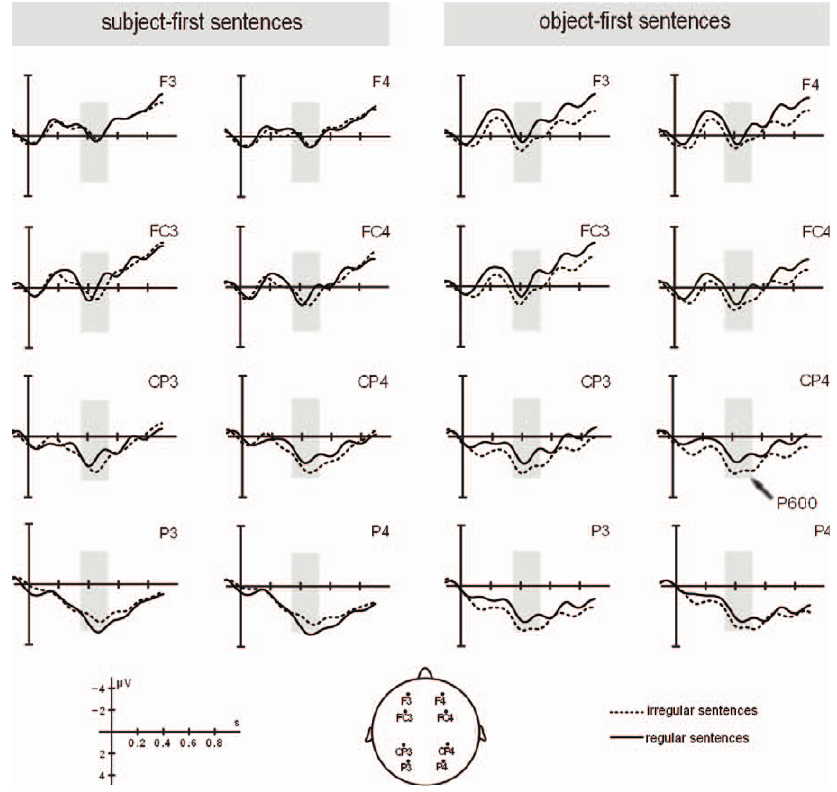
Figure 5. ERP responses for experimental conditions in the time window of interest.